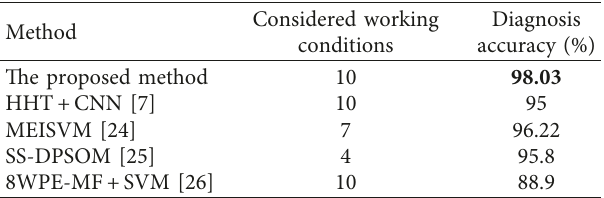
Table 3: Comparison of the proposed method with state-of-the-art